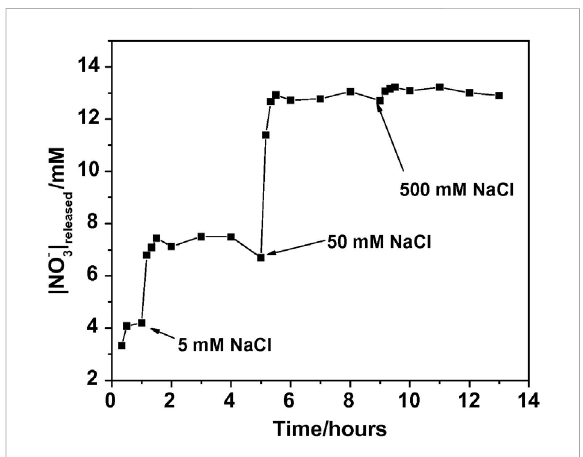
FIGURE 4 Release pro fi les of NO 3 − from Zn – Al – NO 3 LDH (0.5 wt.%) in solution, in the presence of increasing amounts of NaCl. Reproduced from (Tedim et al., 2012) with permission from